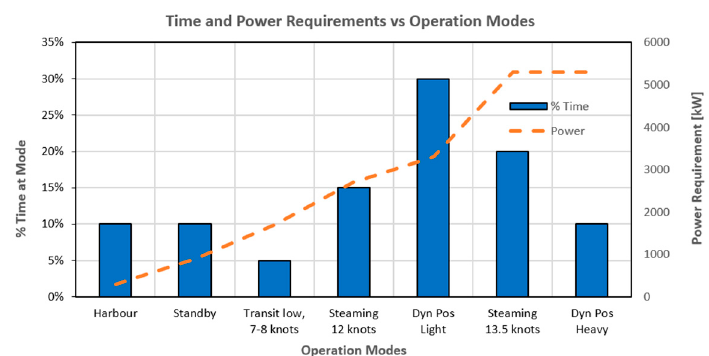
Figure 2. Operational time spent at each mode and resulting engine load. 147 Table 4. Number of operating engines and engine load for di ff erent operation modes.